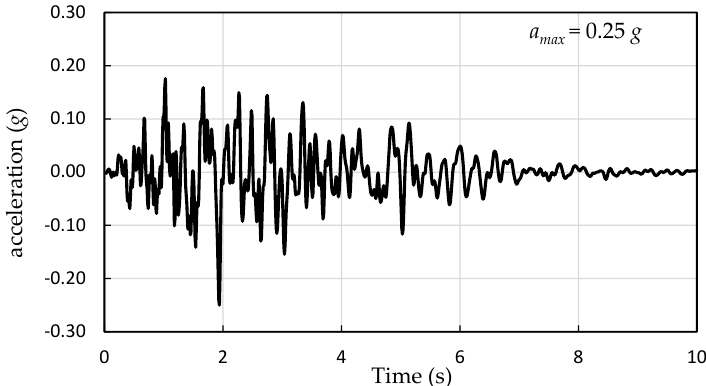
Figure 3. Acceleration time history of the simulated earthquake.